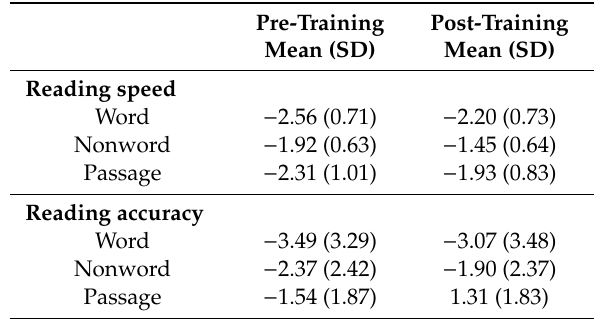
Table 1. Reading variables (z-scores) before and after